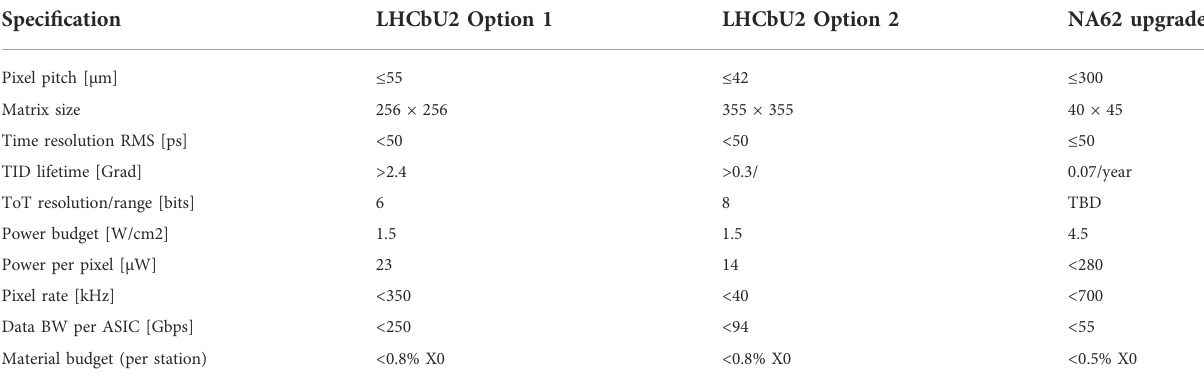
TABLE 1 Target speci fi cations for a pixel read-out ASIC suitable for future